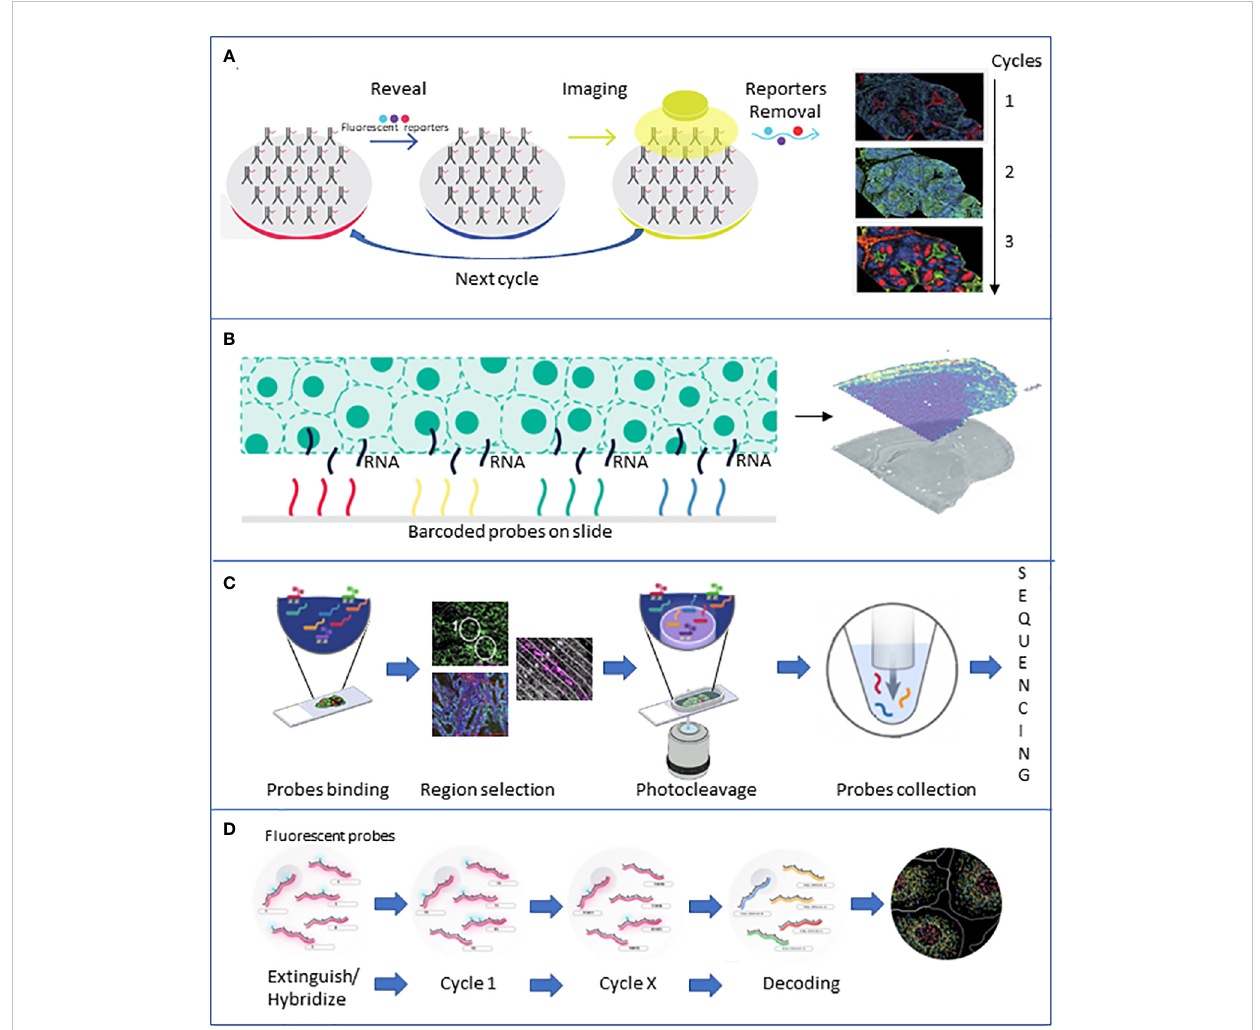
FIGURE 3 Brief description of the major spatial technologies. (A) CODEX is based on a panel of antibodies that binds to speci fi c fl uorescent reporters that reveal their position during the imaging phase. At the end of the fi rst cycle of image acquisition, the reporters are detached, and another cycle with new reporters starts. (B) 10X Visium is based on slides of barcoded capture probes that bind to the polyA tail of RNAs released from the tissue. RNA is retrotranscribed into cDNA and sequenced. (C) GeoMX DSP is based on panels of antibodies or photocleavable barcoded probes. Once an area of interest is selected, a stream of light releases the probes that are lately sequenced. (D) MERFISH is based on fl uorescently tagged probes that label RNA of interest. Sequential rounds of imaging enable spatial resolution. All the pictures have been adapted from the providers ’ web